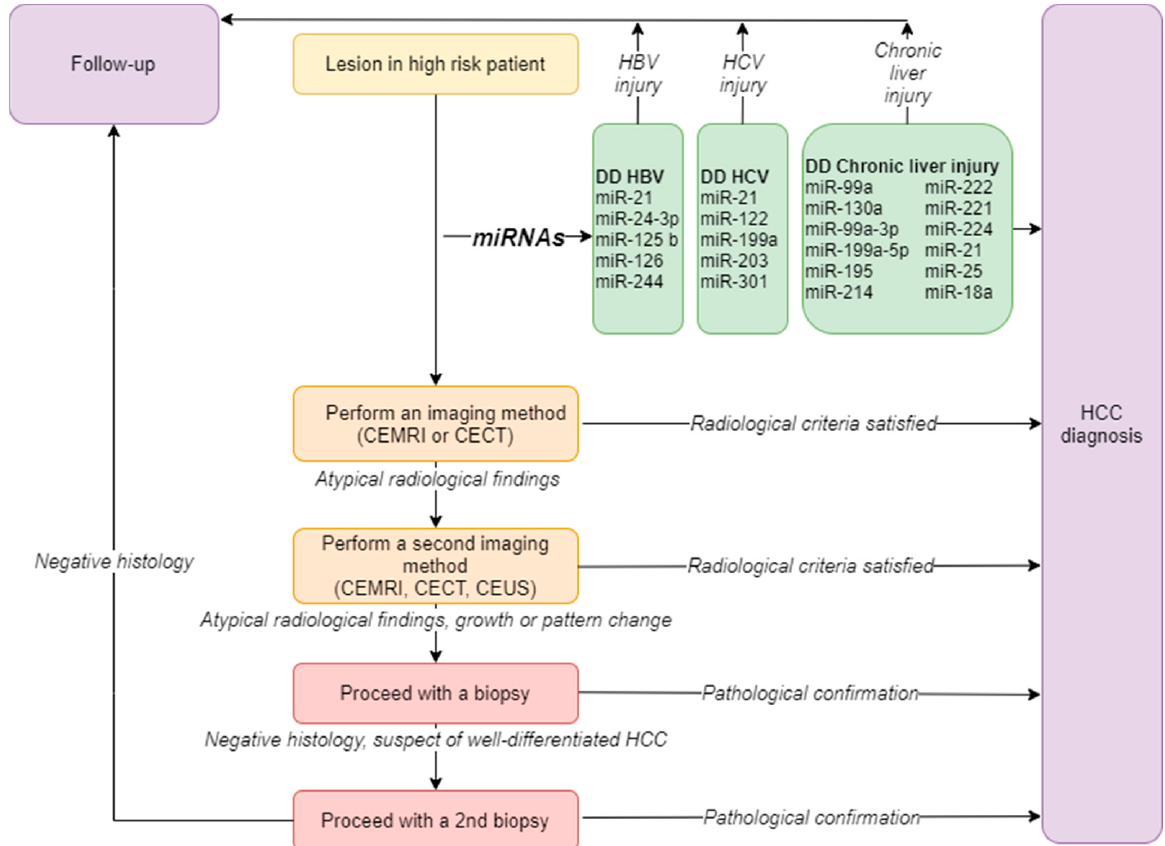
Figure 1. HCC diagnostic flow diagram. According to current guidelines, in case of detection of a suspicious liver lesion, imaging is the main diagnostic tool, followed by pathological diagnosis in case of persistence of atypical characteristics. The introduction of microRNAs analysis in the diagnostic algorithm would allow a more precise differential diagnosis between HCC, HBV, HCV or chronic liver damage. Legend: CECT: Contrast Enhanced-Computer Tomography; CEUS: Contrast Enhanced-Ultrasound; CEMRI: Contrast Enhanced Magnetic Resonance Imaging; DD: differential diagnosis; miRNA: